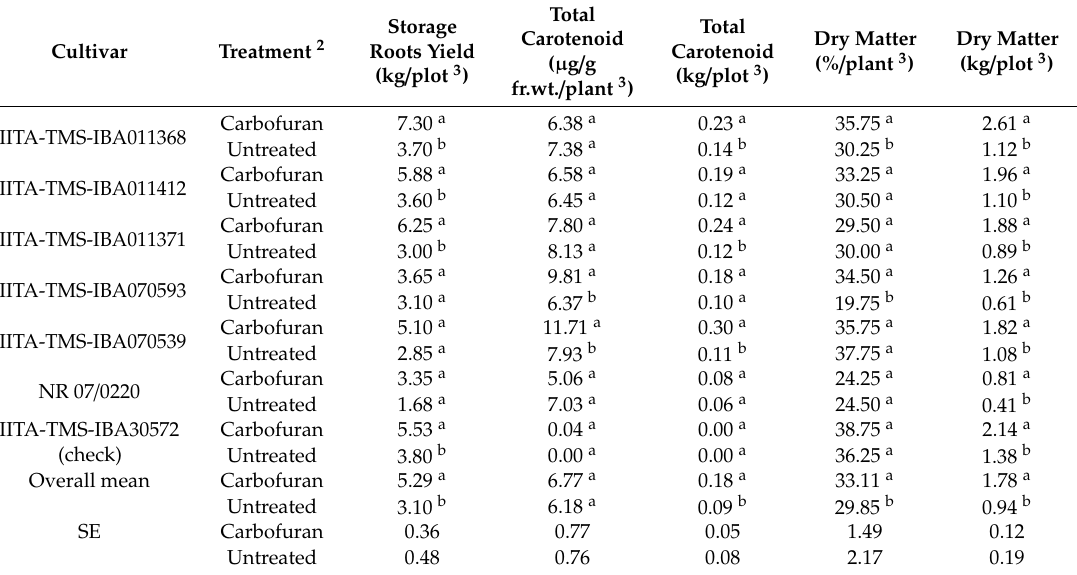
Table 5. Nutritional quality of six biofortified cassava cultivars in field trial in Nigeria 1 .